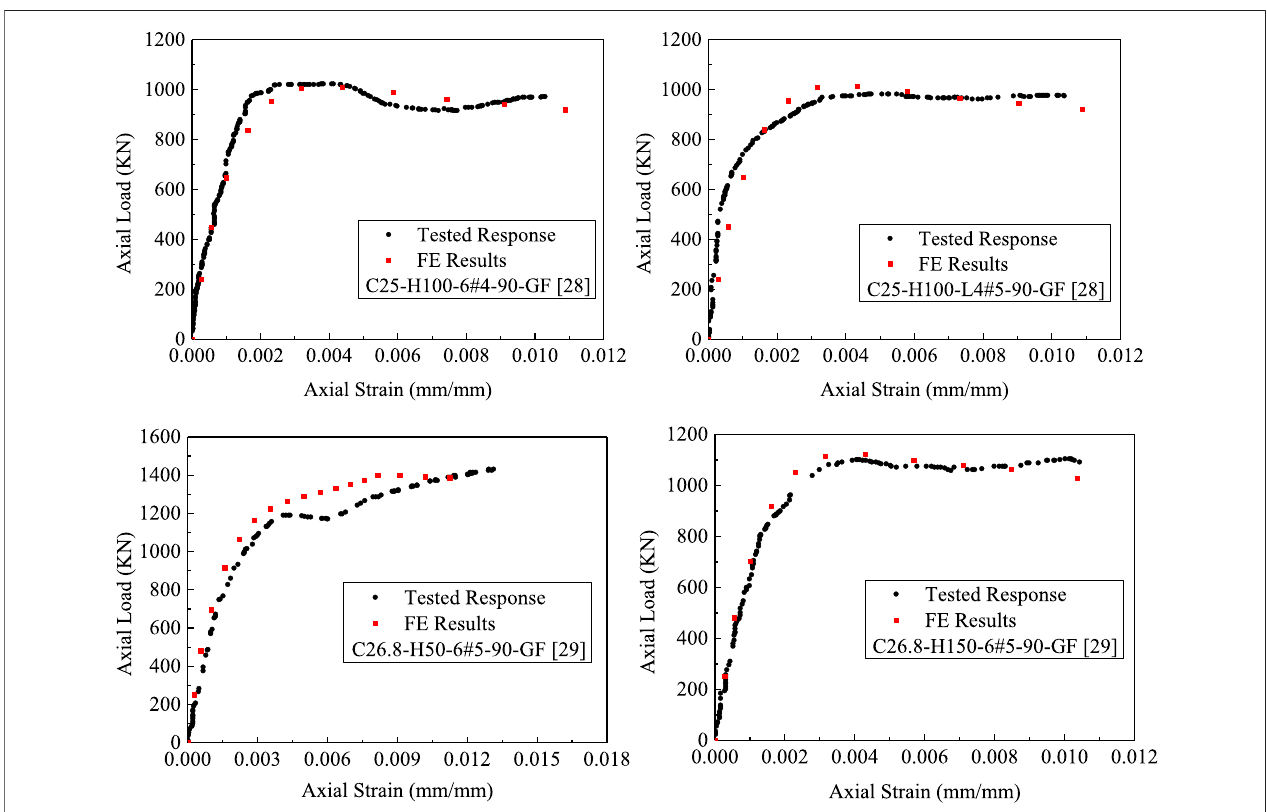
FIGURE 6 | Comparison between selected test responses and FE results of GFRP-RC specimens (AlAjarmeh et al., 2019b; AlAjarmeh et al., 2020).